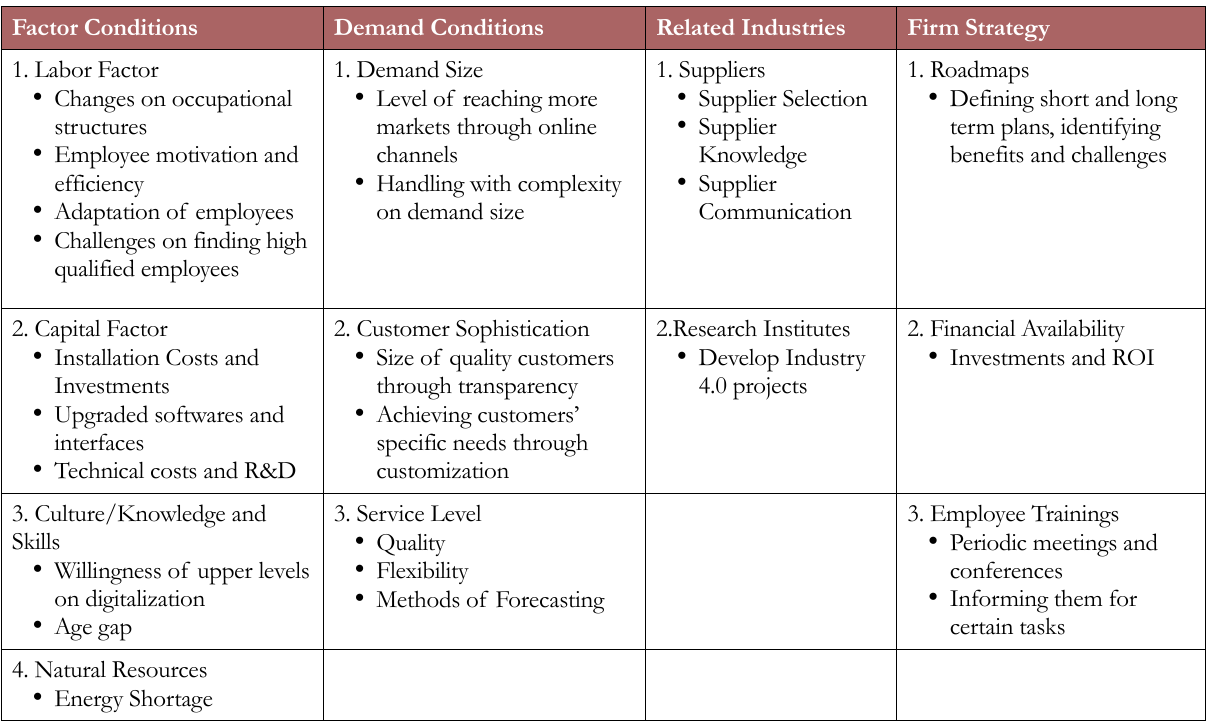
Table 3. The Factors That Affect Industry 4.0 Competitiveness Based On The